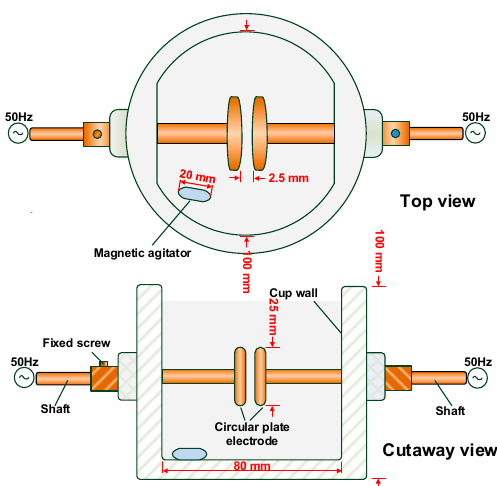
Figure 1. Sketch of the standard AC breakdown oil cup.